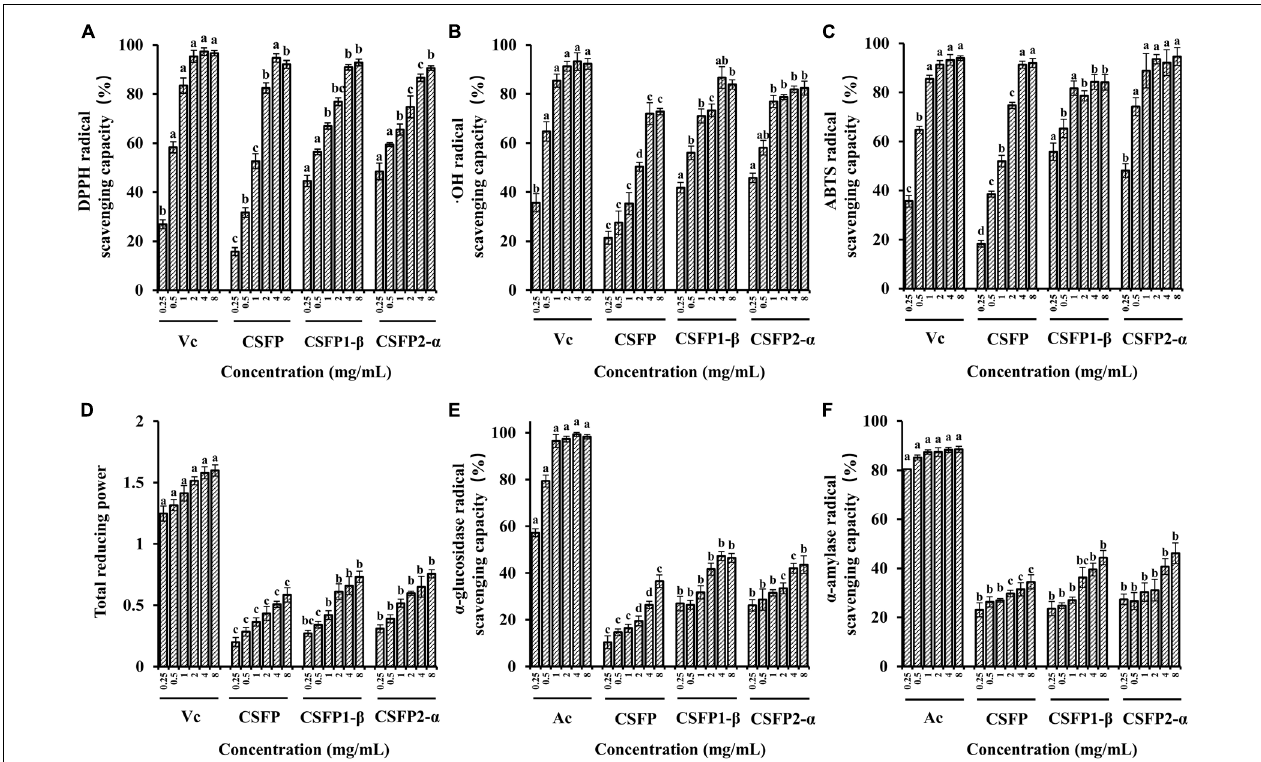
FIGURE 6 | Antioxidant activity and inhibitory enzyme activity of CSFP, CSFP1- β , and CSFP2- α . (A) DPPH radical scavenging capacity, (B) · OH radical scavenging capacity, (C) ABTS radical scavenging capacity, (D) total reducing power, (E) α -glucosidase inhibition capacity, and (F) α -amylase inhibition capacity. Data are expressed as the mean ± standard deviation values ( n = 3), and different lowercase letters denote statistical significance ( p <